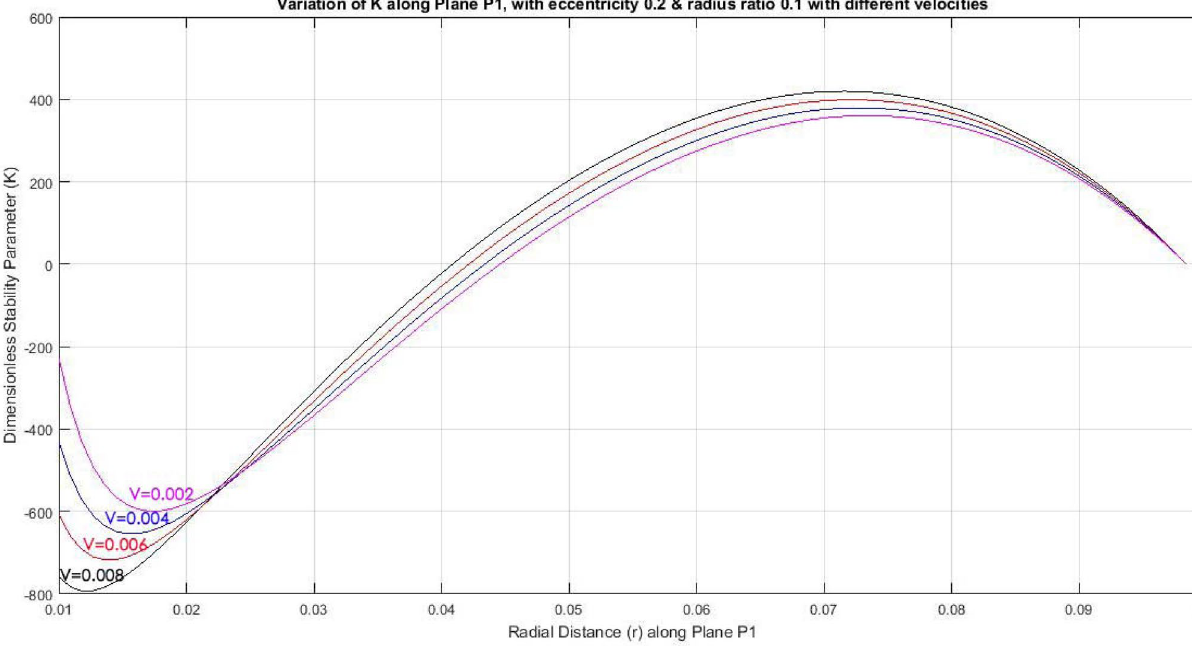
, with eccentricity 0.2 and radius ratio 0.1 for different 1